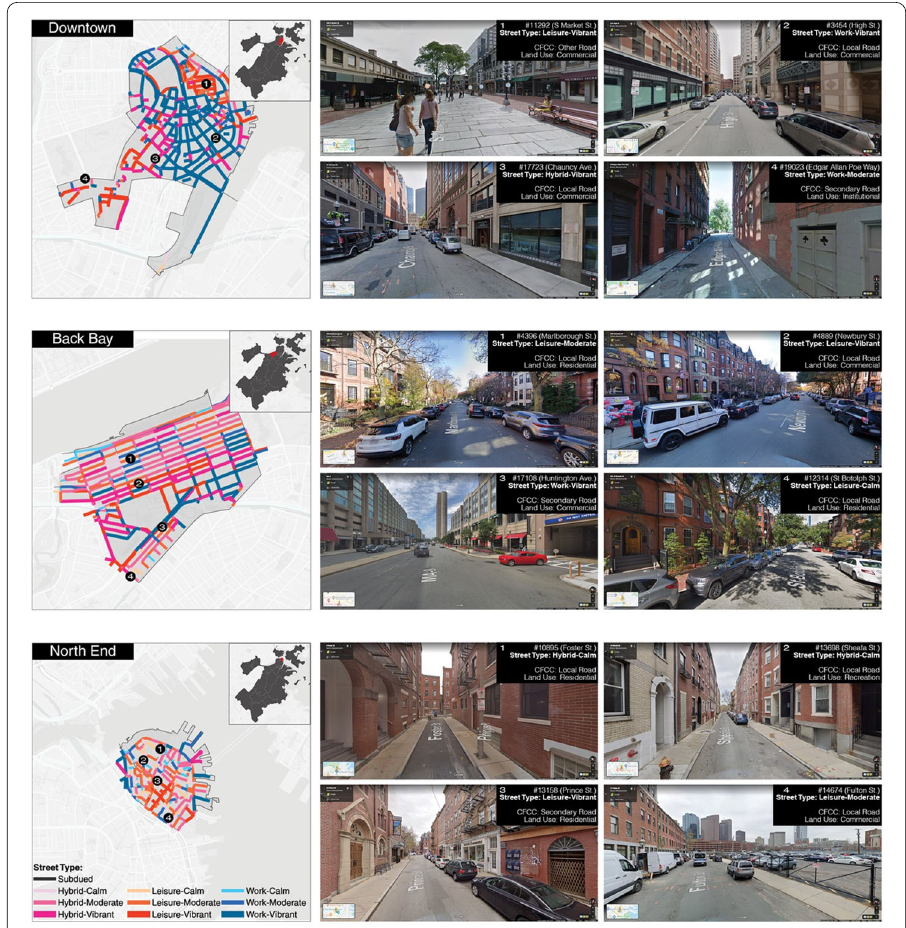
Figure 7 ASTs of three example Boston neighborhoods and information of selected street segments, including Google Street View Images, ASTs, street categories in the functional classification system (i.e.,